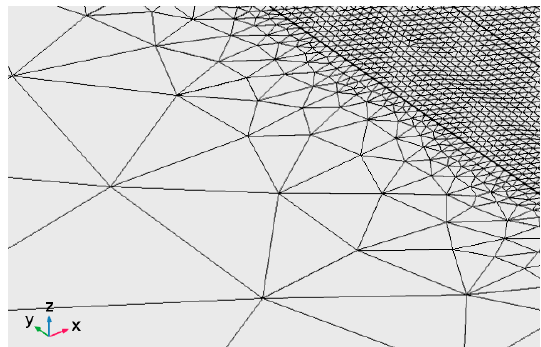
Figure 18. Mesh detail at the interface between the slot and the remaining parent metal; triangle faces in the range from 0.20 to 10 mm edge size.